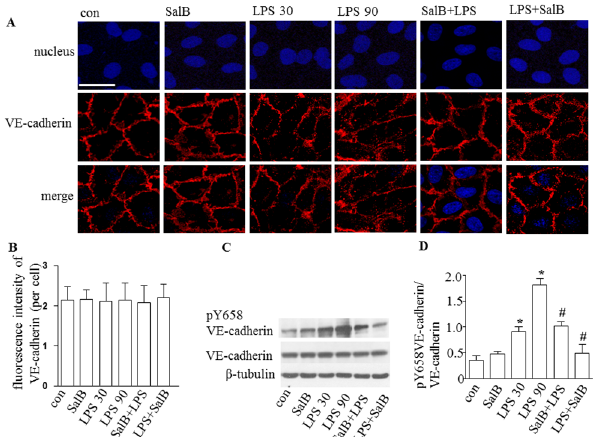
Fig 5. Effect of SalB on the distribution and expression of VE-cadherin in HUVECs. A : Representative images of confocal microscopy showing distribution VE-cadherin (red) in HUVECs in different groups. Hoechst 33342 was applied to stain nuclei (blue).Bar = 25 μ m. B: Quantitative assessment of VE-cadherin in HUVECs. C : Western blot showing protein level of VE-cadherin and phosphorylation of VE-cadherin (Tyr658) in HUVECs in different groups. D : Quantification of Western blot results for phosphorylation of VE-cadherin (Tyr658) in HUVECs in different groups. Data were expressed as mean ± SE of 6 independent experiments. * p < 0.05 vs. control group; # p < 0.05 vs. LPS 30 and LPS 90 groups. One-way analysis of variance (ANOVA) with Turkey post hoc test was used.